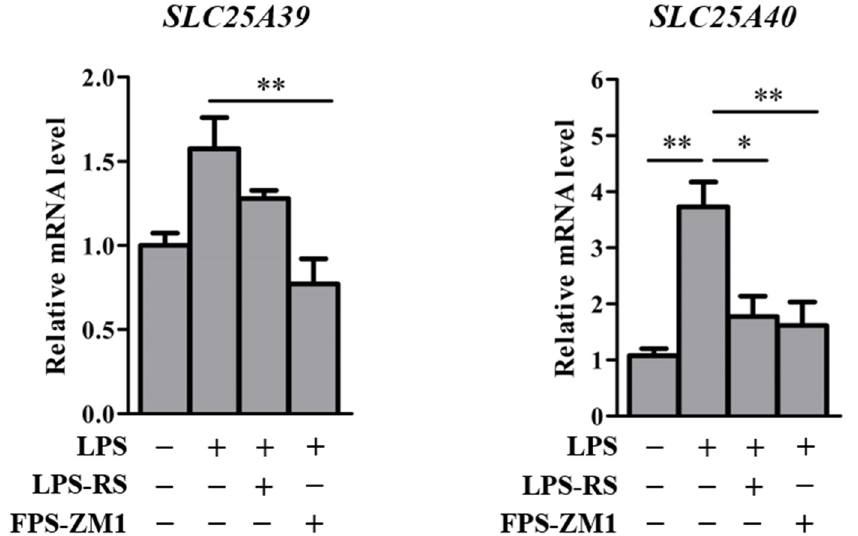
Figure 7. Relative mRNA levels of SLC25A39/40 in the KMRC-1 cells 24 h after treatments of vehicle lipopolysaccharide (LPS) alone (1 μ g/mL), or the combination of LPS-RS (1 μ g/mL) or FPS-ZM1 (1 μ g/mL) and LPS (1 μ g/mL) to KMRC-1 cells. The results are expressed as the mean ± S.E. of each group (n = 3 − 5). Signi fi cant di ff erences (* p < 0.05 and ** p < 0.01) were observed.